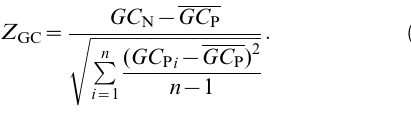
Table S1 Mean and standard error of Z D G for each window.